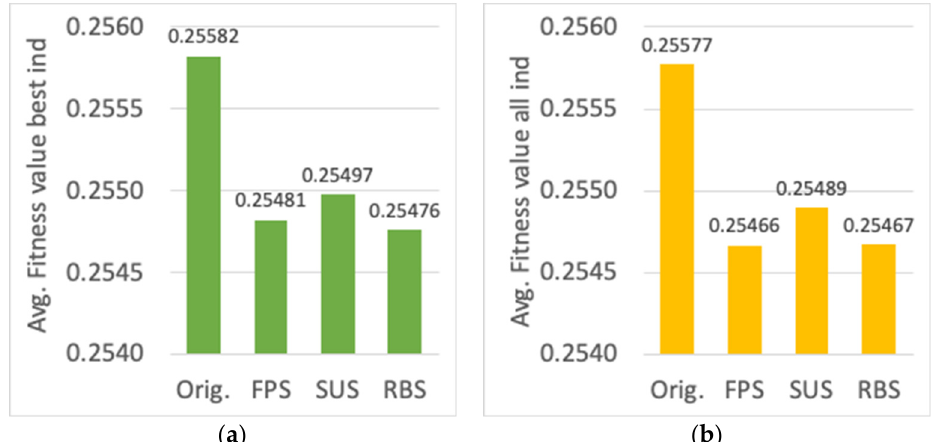
Figure 11. Average fitness value of ( a ) the best individual, ( b ) all the individuals, for different parent selection algorithms.